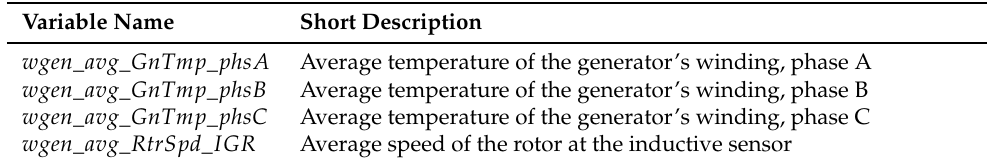
Table 2. Temperature and angular velocity signals corresponding to the generation system used to present the method. The measurements are 5-min averages.